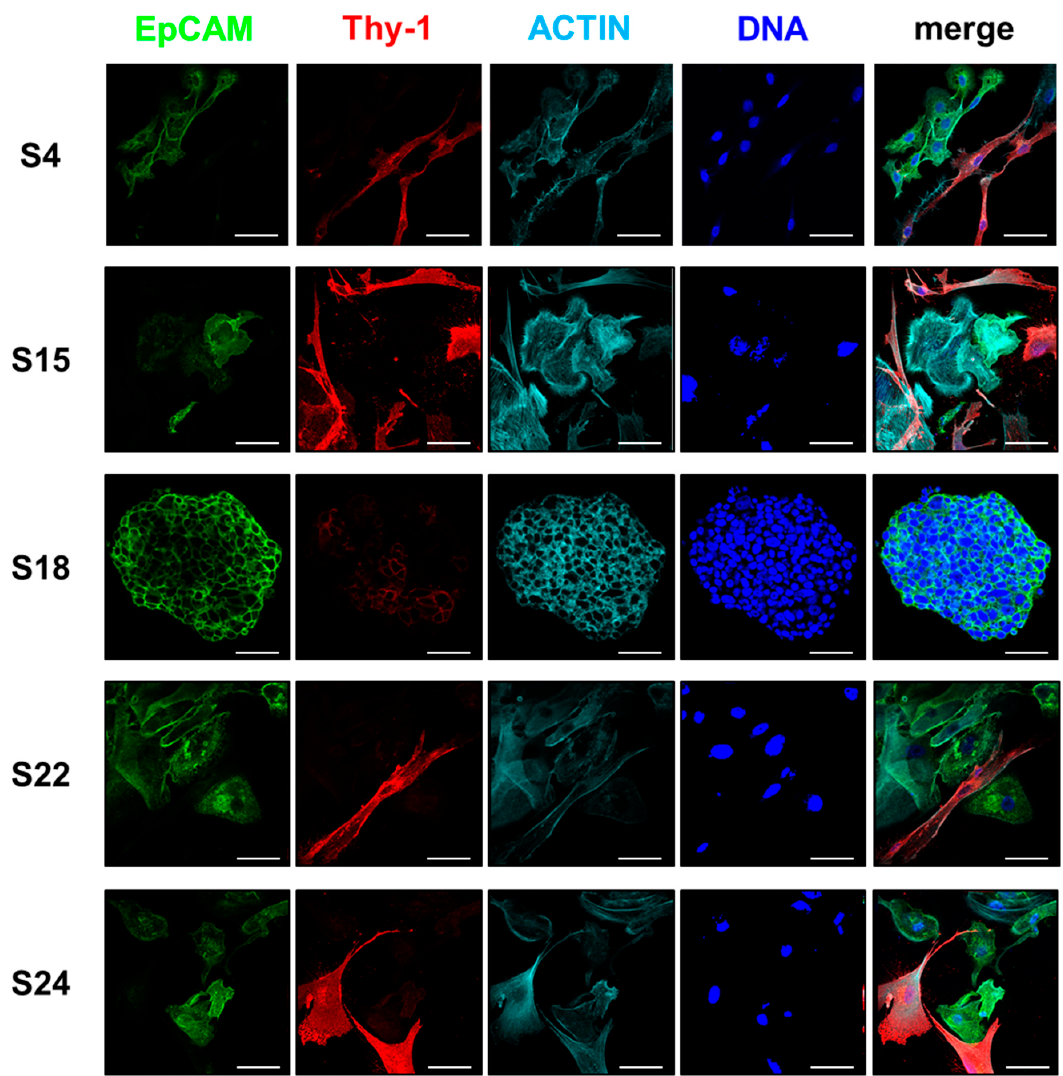
Figure 6. EpCAM and Thy-1 expression in mixed cell cultures composed of epithelial and mesenchymal populations visualized by indirect immunofluorescence. Cells with epithelial morphology stained highly positive for EpCAM, whereas cells with fibroblast-like morphology display high expression of Thy-1. Both markers are mutually exclusive in cell cultures derived from patients S4, S15, and S24. EpCAM positive cells of S18 and S22 showed weak Thy-1 cell membrane localization. Actin was stained using phalloidin to visualize cell morphology; DNA was stained using Hoechst33342; scale bars: 50 µm.